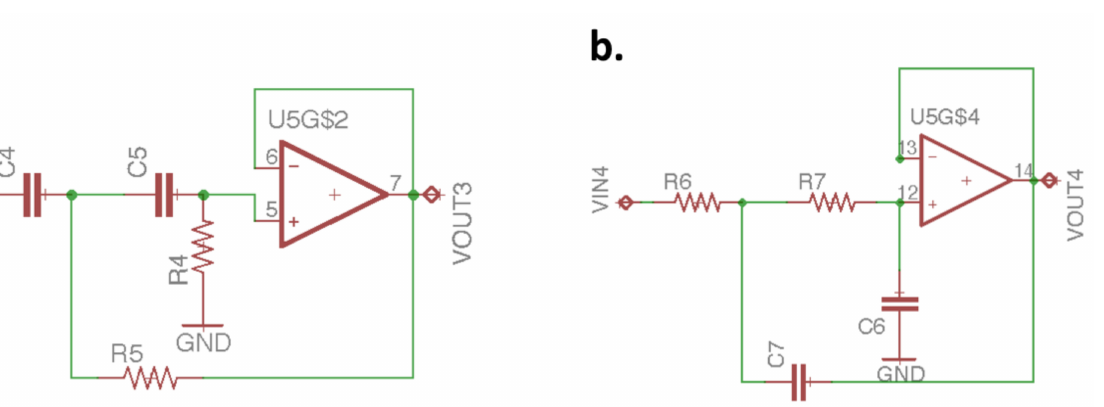
Figure 6. ( a ) Second-order Sallen–Key HPF and ( b ) second-order Sallen–Key LPF. Figure 6b is the second-order Sallen–Key low-pass filters (LPF) [20]; Equation (11) is its transform function calculation formula, and the cut-off frequency is determined by Equation (12). In this study, the cut-off frequency of the LPF is 10.6 Hz; R 6 and R 7 are equal, as are C 6 and C 7, which can attenuate the interference caused by the supply